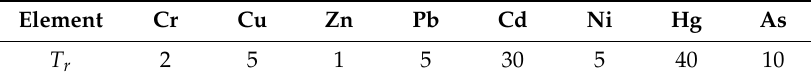
Table 4. Toxic response factors of heavy metals. Element